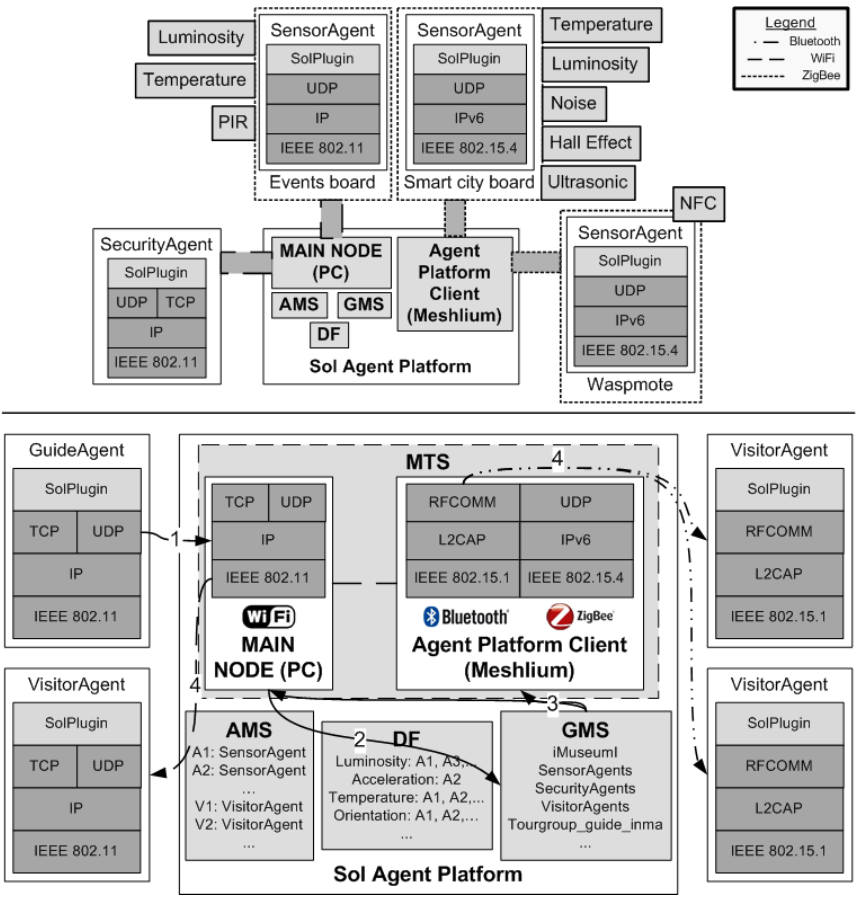
Figure 8. Schema of communication between heterogeneous agents in the devices of the iMuseumA (intelligent museum with agents) ( top ); and group communication inside the iMuseumA ( bottom